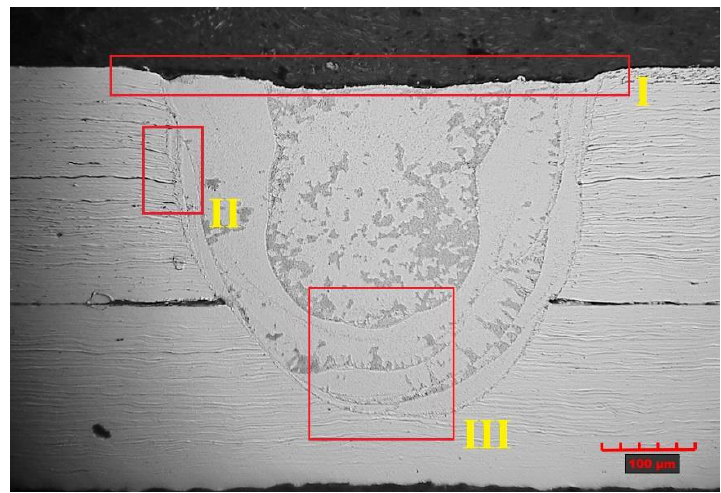
Figure 6. Structure of the weld with the characteristic areas of the joint marked. I – weld face, II and III - the fusion penetration line of the weld into the base material.